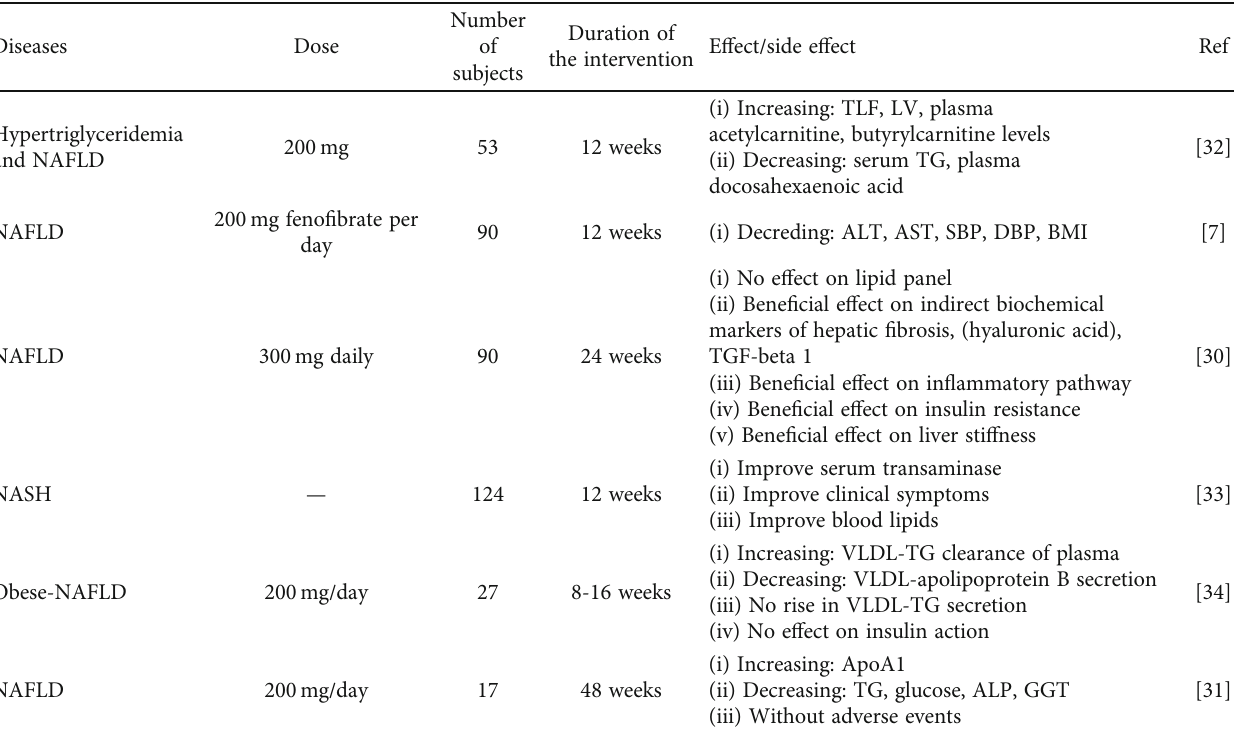
Table 1: Di ff erent human studies of feno fi brate on